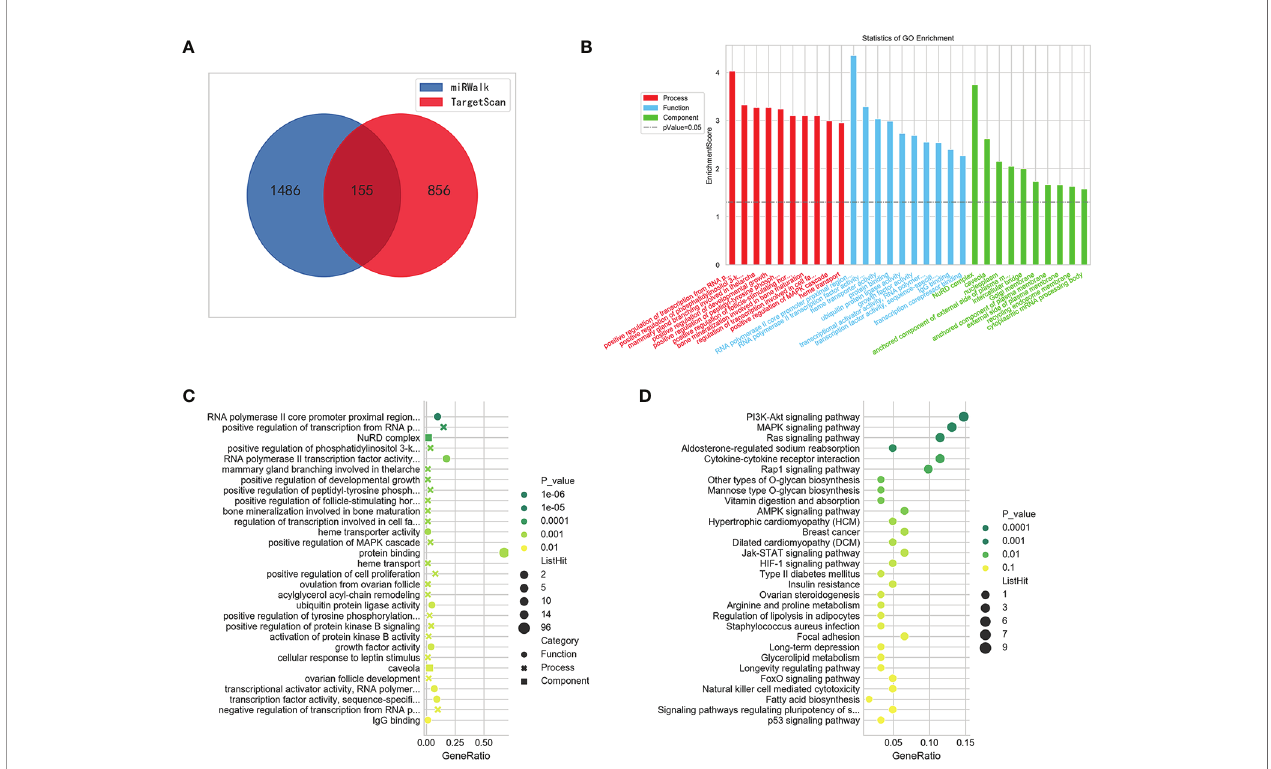
FIGURE 6 | Bioinformatics analysis of miR-1539. (A) 155 potential genes were discovered by intersection of target genes prediction from miRWalk and TargetScan datasets. (B) GO enrichment: Potential target genes were classi fi ed by three functional categories: biological process, molecular functions, and cellular component (p < 0.05). TOP 10 potential target genes of each item were displayed in the bar plot. (C) GO enrichment: bubble plot showed TOP 30 most signi fi cant items of potential target genes in all functional categories for miR-1539 (p < 0.05). The top signi fi cantly target genes and scores were listed as y-axis and x-axis, respectively. (D) KEGG pathway analysis indicated that miR-1539 was observably enriched in cancer signaling pathway, using the DAVID. The enriched pathways and scores were listed as y-axis and x-axis,